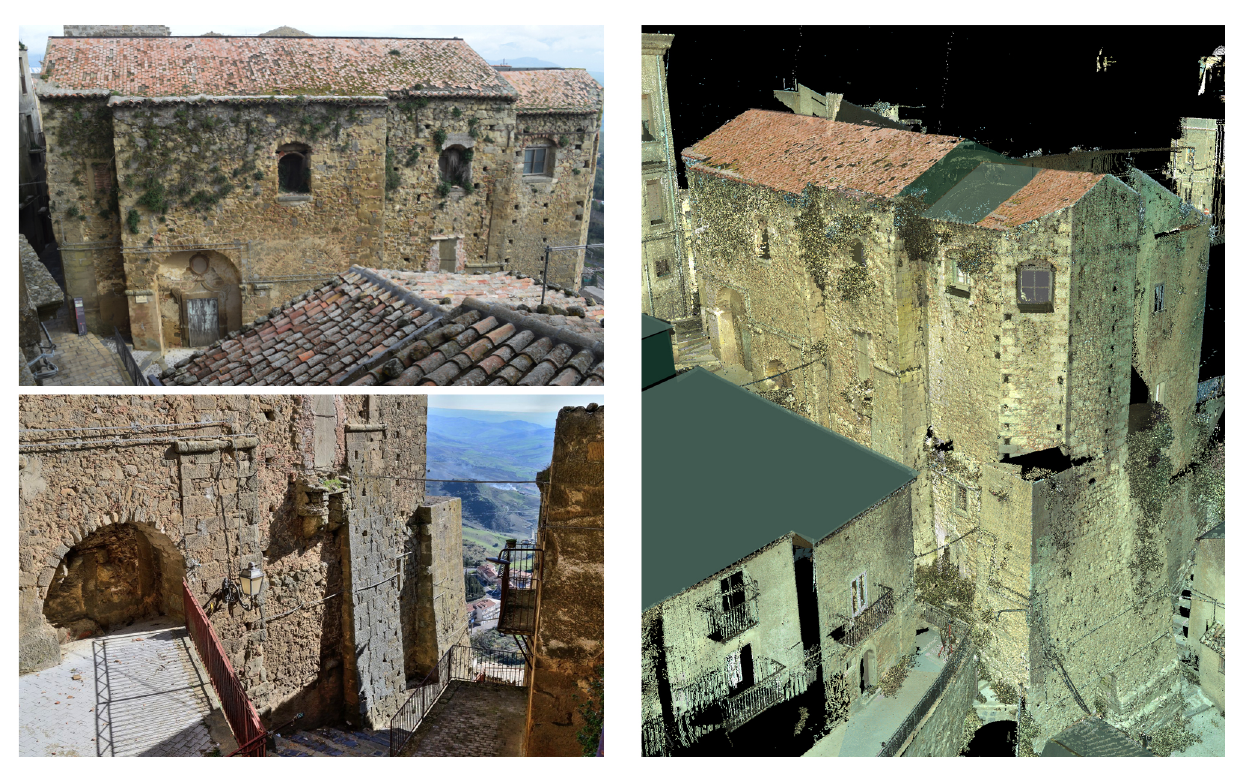
Fig. 2: Conventual complex and urban context. Fig. 3: Aerial view of the 3D